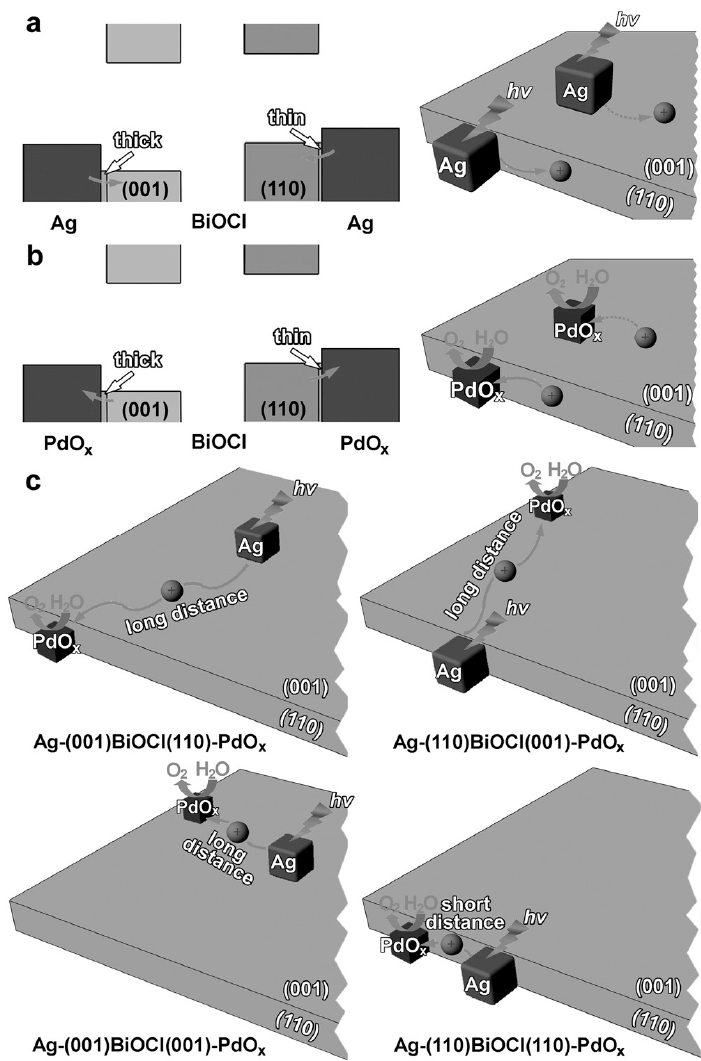
Figure 8. Schematic depicting the facet-dependent interfacial hole transfer ability as a result of the difference in thickness of the contact barrier layer on ( a ) Ag-BiOCl and ( b ) BiOCl-PdO x interfaces. ( c ) Schematic representation of the different average diffusion distances of hole in different Ag-BiOCl- PdO x photocatalysts. Reprinted from Ref. [197] with permission from John Wiley &